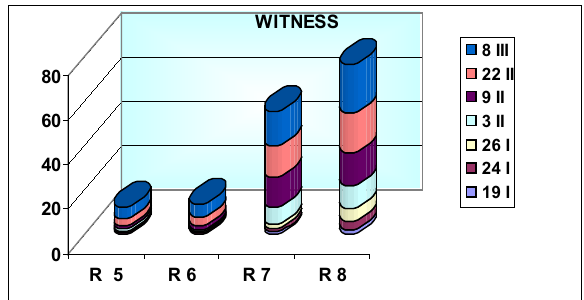
Fig. 4. The final average length of the branches, in cm, for wit- ness